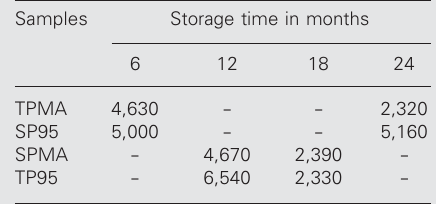
Table 4. DNA extracted from different samples stored for different